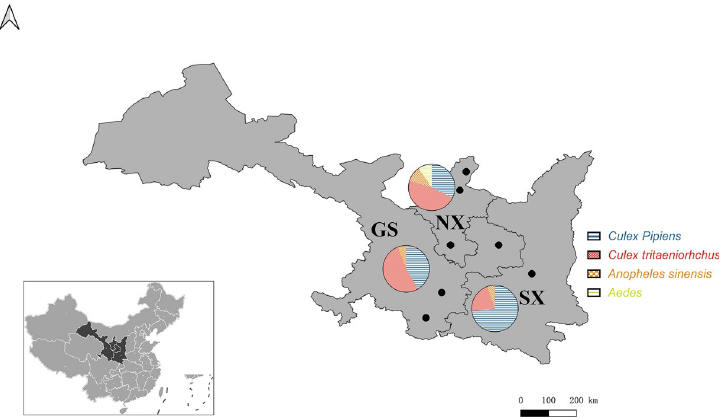
Fig 1. Map of mosquito collection sites. The Shanxi-Gansu-Ningxia region is labeled in light gray and cities where the collection sites were located are indicated with black dots. The pie charts on the map show the composition of mosquito species collected in each province, with each color representing a mosquito species. The location of the Shaanxi-Gansu-Ningxia region is shown in dark gray on the map of China in the lower left of corner (GS: Gansu Province, SX: Shaanxi Province, NX: Ningxia Hui Autonomous Region). The base layer of this modified map originated from National Earth System Science Data Center, National Science & Technology Infrastructure of China